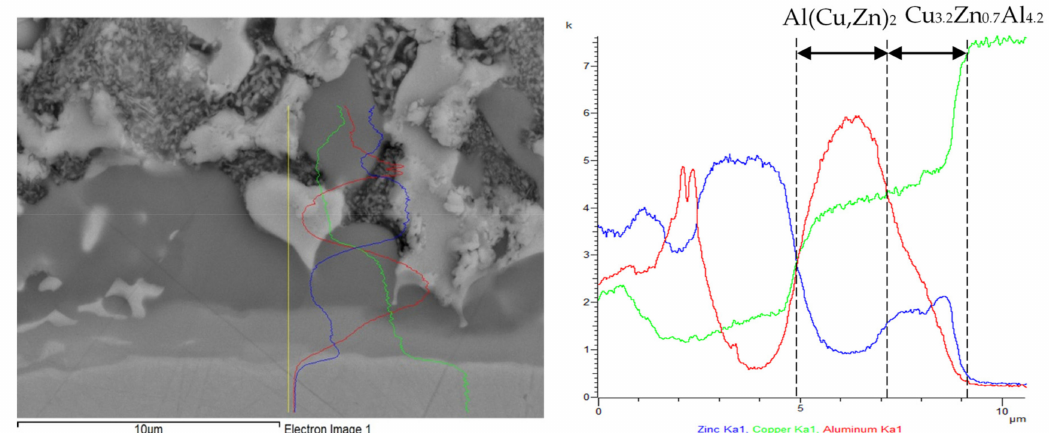
Figure 18. Concentration profiles of Al, Cu, and Zn elements in the Cu/Zn5Al3Cu